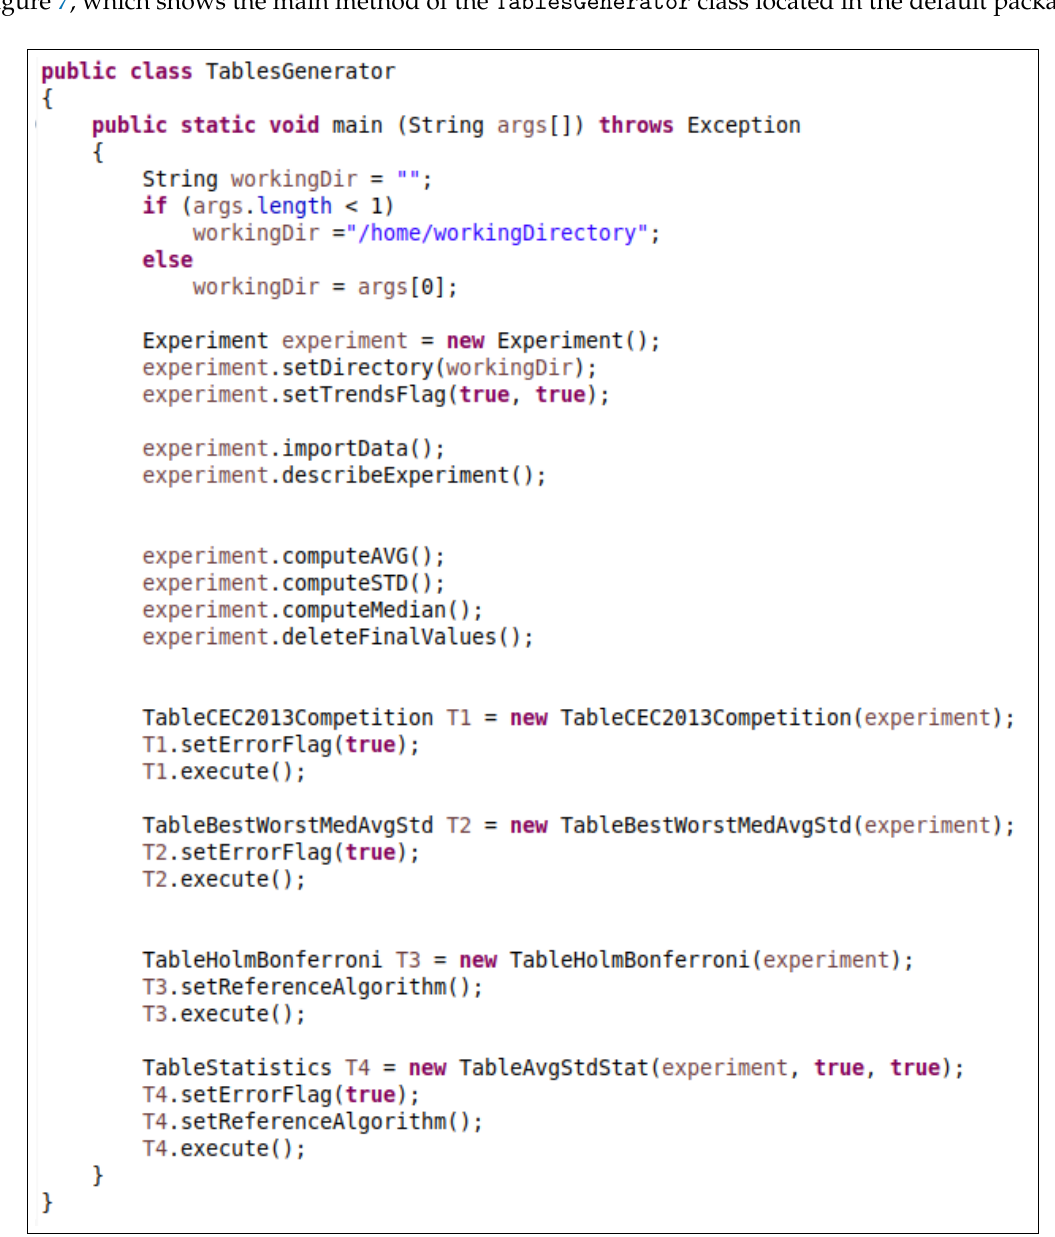
Figure 7. An example of the TablesGenerator class containing methods for visually displaying results in several different